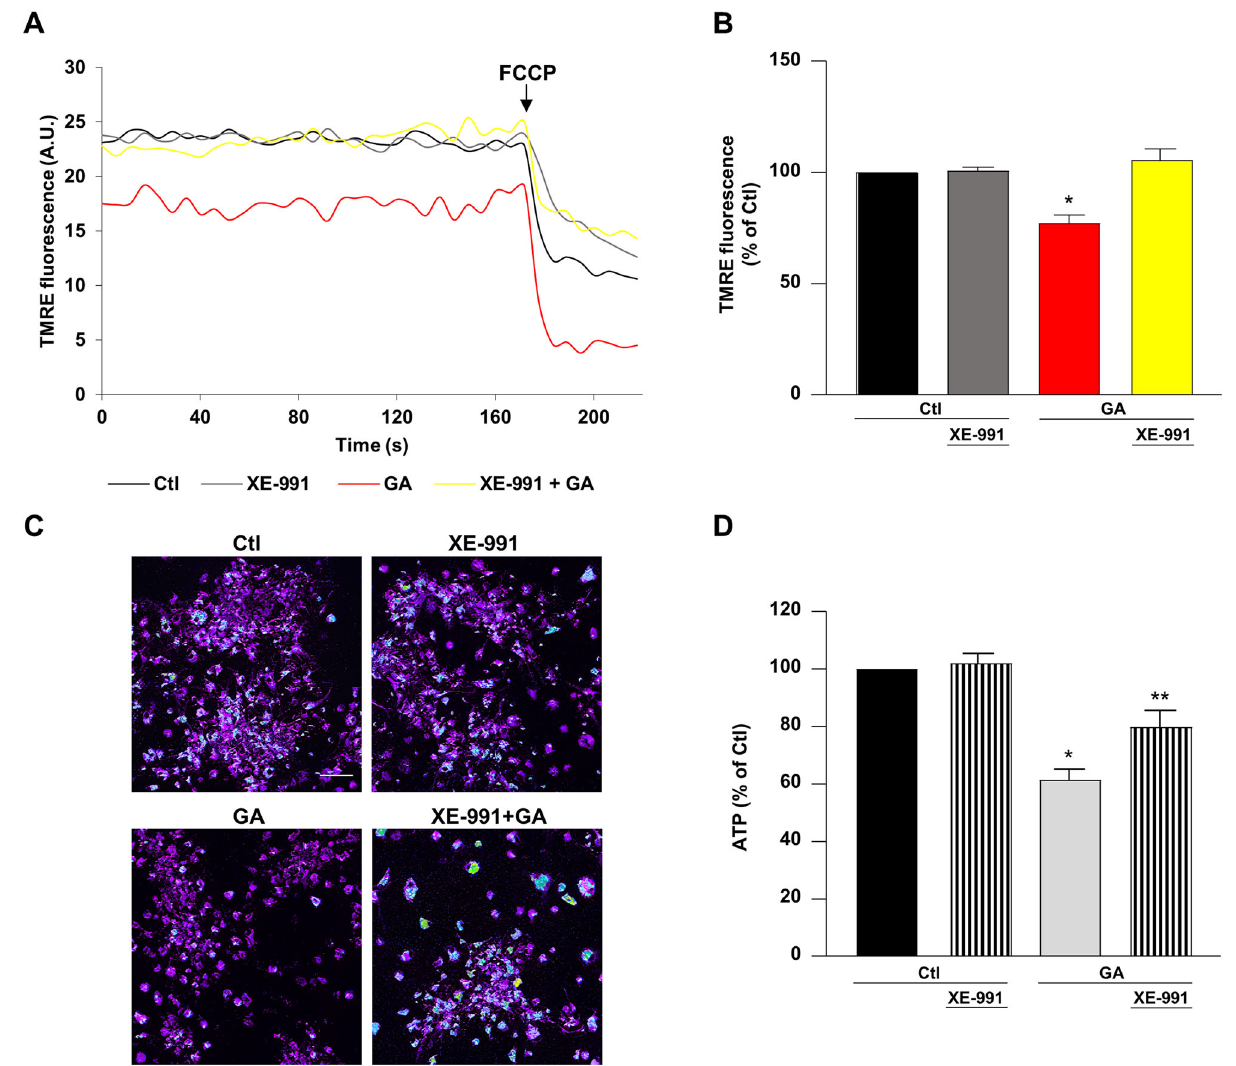
Fig. 4 Effect of XE-991 on mitochondrial membrane potential and ATP production in GA challenged primary rat cortical neurons. A Representative records showing mitochondrial membrane potential measurements under different experimental conditions, namely control (black line), exposure to XE-991 (gray line), 24 h of GA challenge (red line), and 24 h of GA challenge in the presence of XE-991 (yellow line). B Quanti fi cation of mitochondrial membrane potential and D ATP production under different experimental conditions. C Representative pictures of mitochondrial membrane potential measurements. Scale bar 50 µm. In each experiment intracellular TMRE fl uorescence and ATP levels were reported as control percentages. Differences among means were evaluated by one-way ANOVA followed by Dunnett ’ s post hoc test. A , B After permeabilizing cells with digitonin (5 µM), mitochondrial membrane potential was evaluated by using a nonquenching concentration (10 nM) of the inner mitochondrial membrane potential indicator TMRE. FCCP (20 µM) was added at the end of the recording session as internal control. B F (3, 12) = 15.57. Each column depicts the mean ± S.E.M. of 50 – 100 cells recorded in four different sessions. *Signi fi cant versus all groups ( p < 0.001). D F (3, 37) = 24.03. Each column depicts the mean ± S.E.M. of at least four independent experiments that were performed in triplicate. *Signi fi cant versus all groups ( p < 0.0001 versus control groups and p < 0.01 versus XE-991 + GA); **signi fi cant versus all groups ( p < 0.001 versus Ctl, p < 0.05 versus XE-991, and p < 0.01 versus